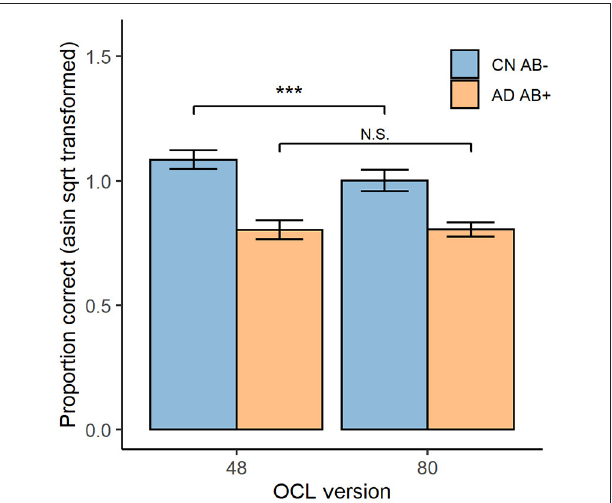
FIGURE 3 | OCL48 and OCL80 Performance for CN A β − and AD A β + participants. Overall performance on both the OCL48 and OCL80 tests for both cognitively normal beta-amyloid negative (CN A β − ; blue) and Alzheimer’s Diseased beta-amyloid positive (AD A β + ; orange) groups. Error bars represent 95% confidence intervals of the means. Asin sqrt, arcsine square root N.S., non-significant. *** p < 0.001.